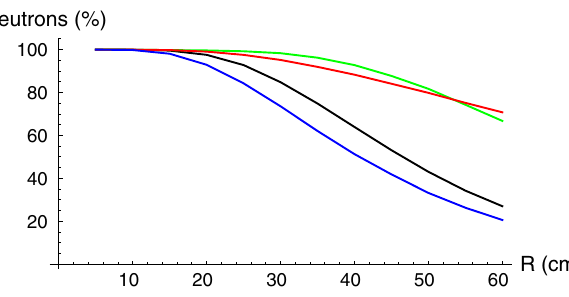
Fig. 4 (Left) The percentage of initially monochromatic 1 MeV neu- trons which escape a spherical converter. (Right) The percentage of ini- tially monochromatic 1 MeV neutrons whose energy never falls below